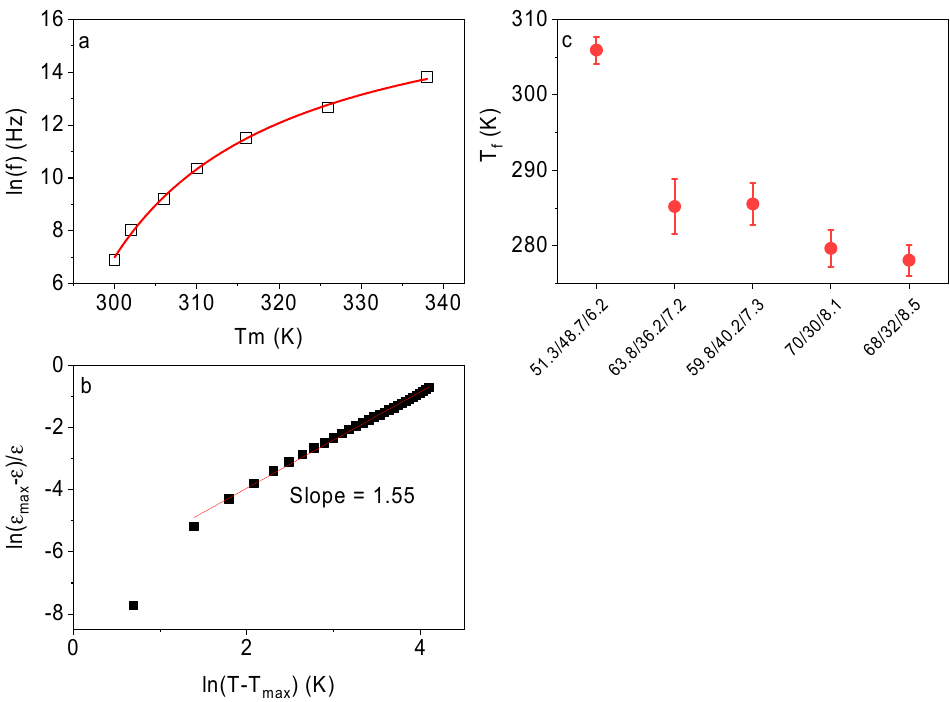
Figure 3. Examples of ( a ) the Vogel-Fulcher and ( b ) the modified Curie-Weiss law fitting for the P(VDF-TrFE-CFE) 68/32/8.5 film. ( c ) The freezing temperatures, T f , of the studied samples.